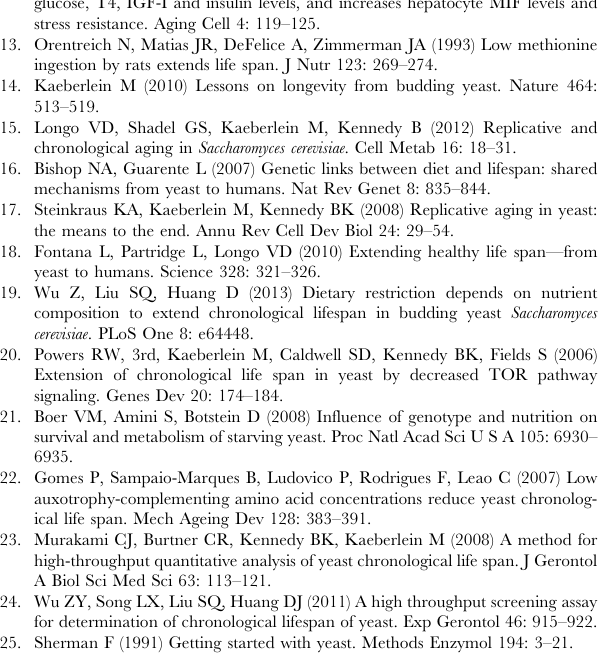
using Duncan’s multiple range test at P , 0.05. Different lowercase letters in columns indicate significant difference. (TIF) Figure S4 The combination treatment is sufficient to extend yeast lifespan. Survival curves of wild type yeast (BY4742) were cultured in different media. The combination treatment (0.1 6 Met + 20 6 Glu) greatly extends lifespan in CR, 1E5N and pH buffered conditions, except in buffered 1E1N medium with 2% glucose. All tests are based on SD media. 1E5N represents SD medium containing 1-fold EAA and 5-fold NEAA. (TIF) Figure S5 Acetic acid may be not the cause of lifespan shortening in buffered media (pH 6.0). ( A ) The pH of the four buffered media changed slightly under normal and CR conditions. The pH was measured at stationary phase (day 2) of yeast cultured in 1E1N medium without (normal) or with low methionine (0.1 6 Met), high glutamic acid (20 6 Glu) or a combination of both (0.1 6 Met + 20 6 Glu). Acetic acid accumulation in the four aging media (control, 0.1 6 Met, 20 6 Glu and 0.1 6 Met + 20 6 Glu) under normal and CR conditions with ( B ) or without pH buffering ( C ). Data expressed as mean 6 s.d (n= 3) and datum 0.0 means not detectable. Figure S6 Comparative evaluation of the pH of aging media in WT, sch9 D and gcn2 D . The pH was measured at stationary phase (day 2) of yeast cultured in 1E1N (normal) and 1E5N media without (control) or with low methionine (0.1 6 Met), high glutamic acid (20 6 Glu) or a combination of both (0.1 6 Met + 20 6 Glu). 0.5% glucose (CR) caused higher pH than 2% glucose in the eight media in the three strains, while the pH varied slightly among the four treatments (control, 0.1 6 Met, 20 6 Glu and 0.1 6 Met + 20 6 Glu) under the same condition (1E1N or 1E5N) and the same strain. Differences in means of the pH values of different media under normal (2% glucose) or CR conditions, respectively, were analyzed by Duncan’s multiple range test at P , 0.01 and